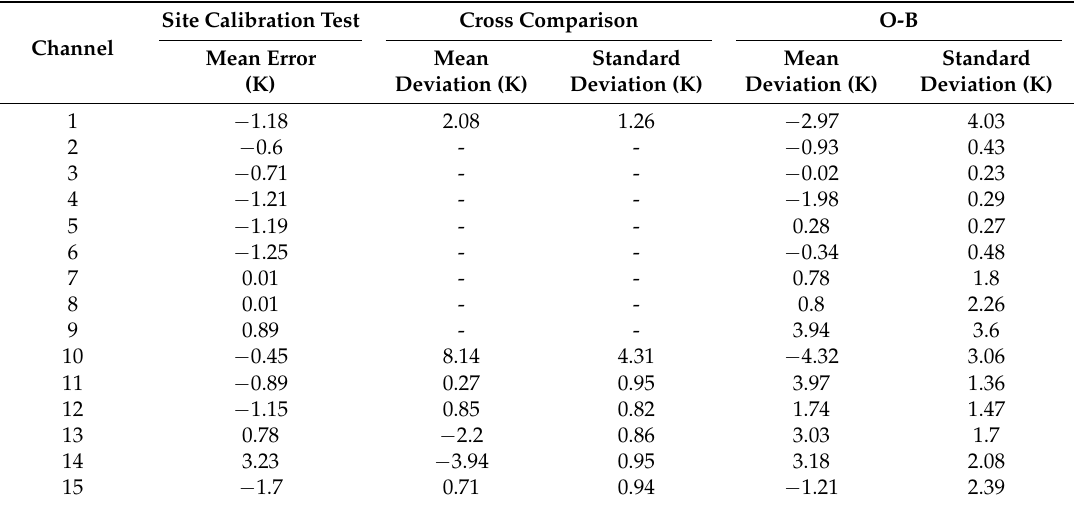
Table 2. The calibration results of MWHTS measurements